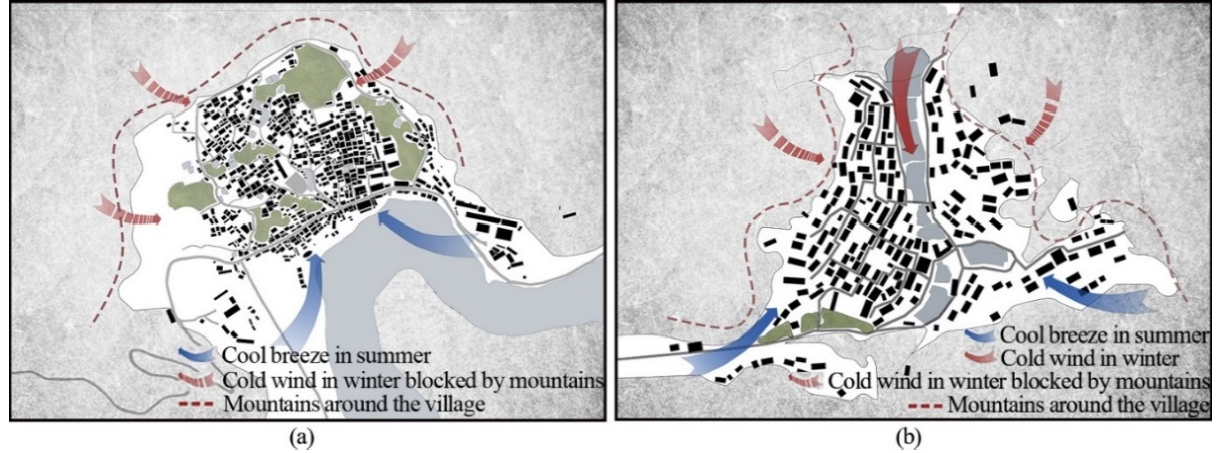
Figure 3. ( a ) The layout of the High chair Village and its prevailing winds; and ( b ) the layout of the Shujiatang Village and its prevailing winds. (2) Village Layout